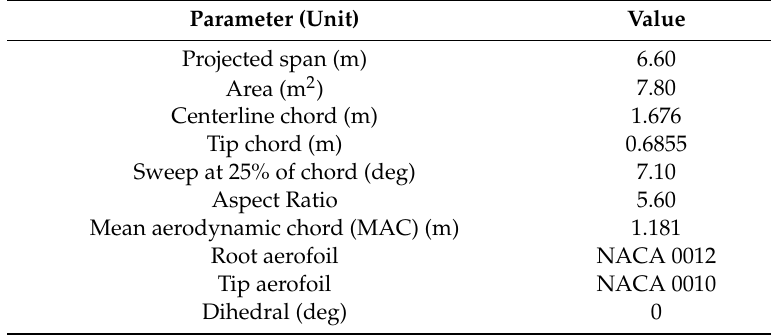
Table 5. Horizontal tail plane geometrical reference data (geometry information from [25,26]).